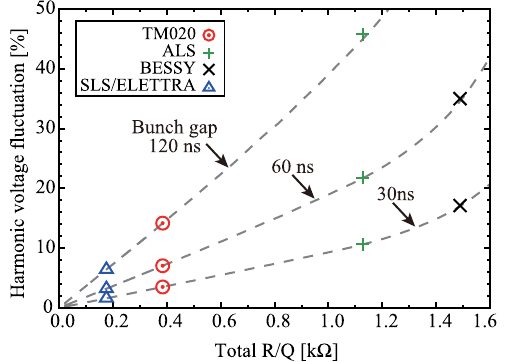
FIG. 7. Estimated fluctuations in the harmonic rf voltage as a =Q . We assumed bunch-gap durations of 30, function of total R n 60, and 120 ns, and a beam current of 500 mA. The symbols indicate the results for the 1.5-GHz harmonic cavities given in Table IV. Each dashed line represents the curve which fit the results for many sets of parameters with a fixed bunch gap.